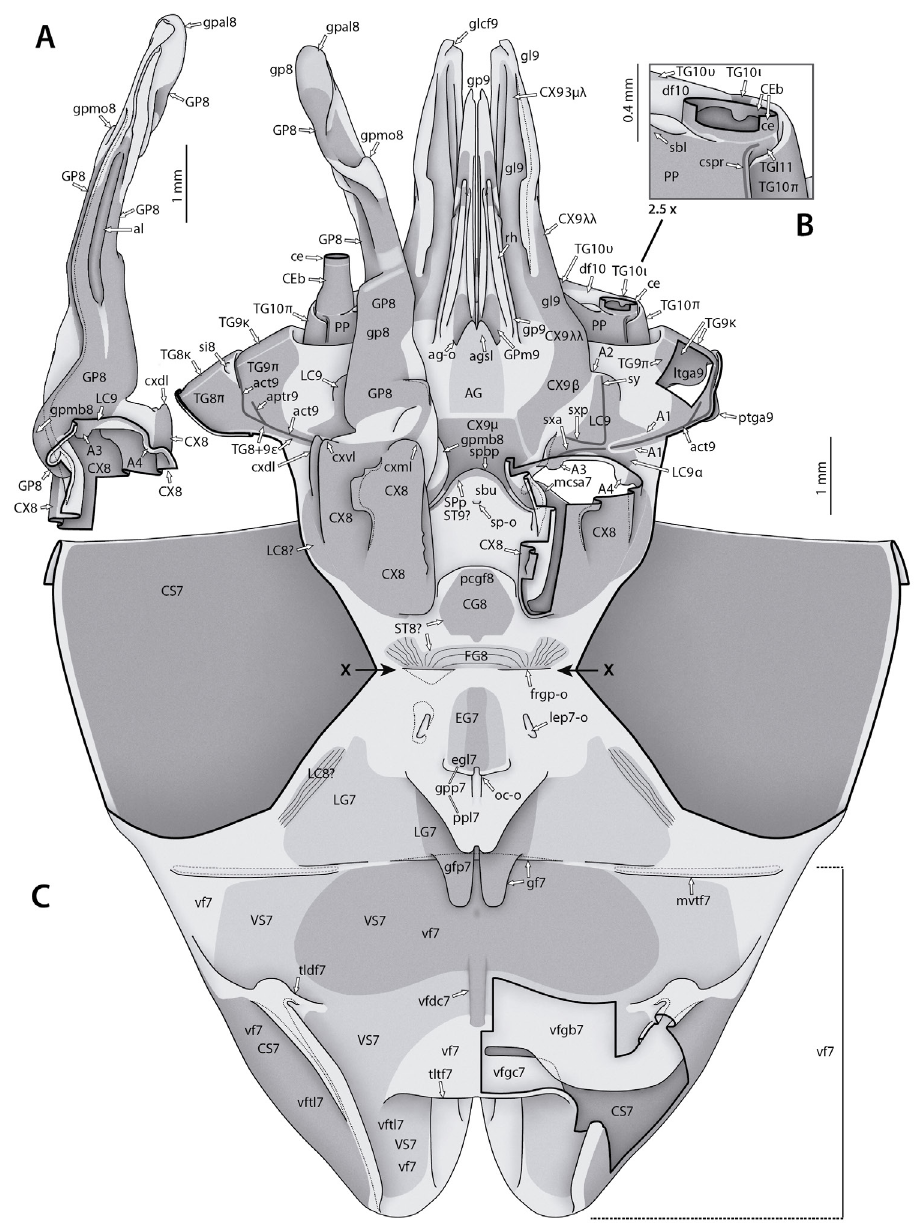
Figure 14. Annotated illustrations of the female Sphodromantis sp. postabdomen and genitalia for mor- phological use. A left gonapophysis 8 with adjoining parts of coxa 8 and laterocoxa 9 in dorsal view B lateral parts of terminal abdomen in ventral view, with focus on base of cercus (enlarged 2.5× from C ) C entire genital region, most parts in external view. Posterior parts (segments VIII–XI) are bent 180° dor- sally and to the anterior compared to anterior parts (of segment VII), along the axis marked by arrows